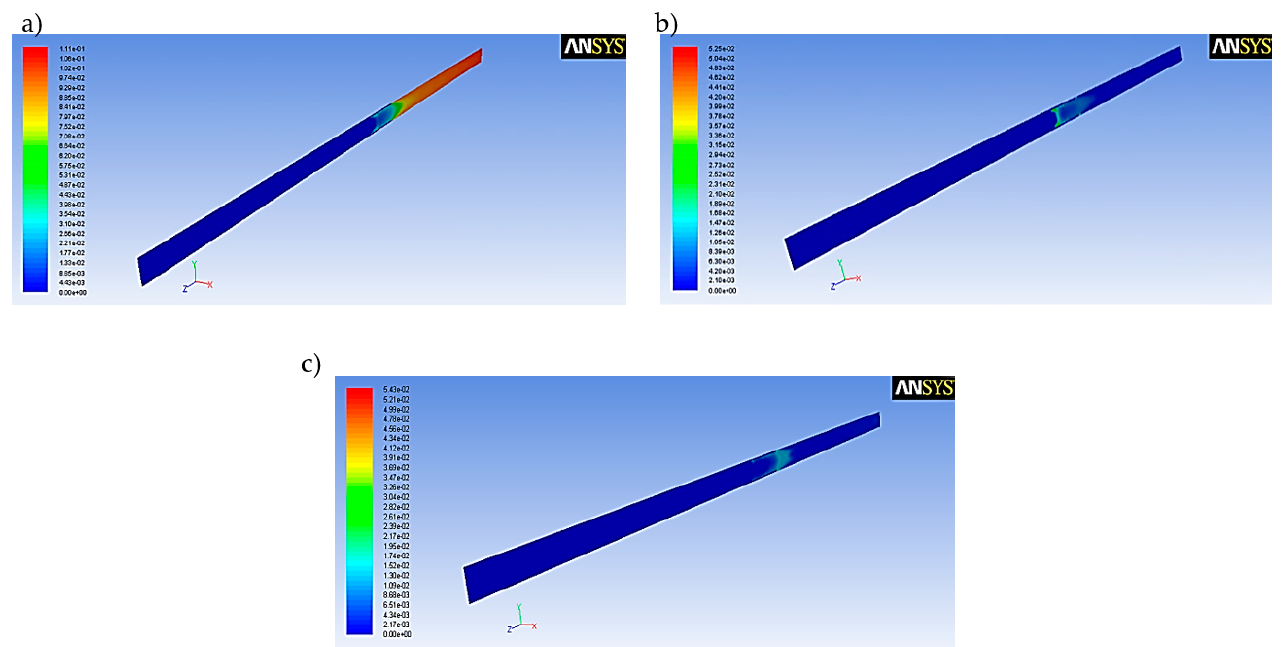
Figure 27. Map of CH 4 variations in the syngas for the numerical simulation: ( a ) coal sample from hard coal mine A in 1040 s, ( b ) coal sample from hard coal mine B in 704 s, ( c ) coal sample from hard coal mine C in 545 s.